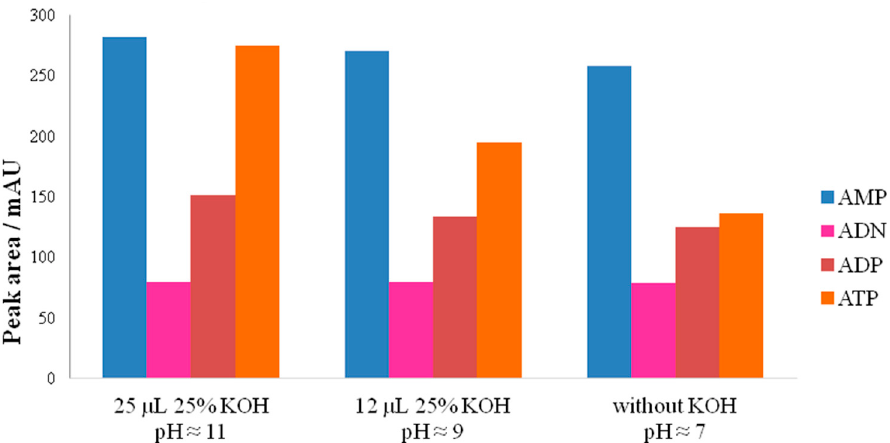
Figure 2. Column charts representing the mean peak areas of adenylates extracted with 0.5 M PCA from G. fossarum samples (N = 6) after using three different neutralization solutions: neutralization with 25 µ L of 25% KOH (pH ≈ 11) and phosphate buffer; neutralization with 12 µ L 25% KOH (pH ≈ 9) and phosphate buffer; and with no phosphate buffer nor KOH added (pH ≈ 7).